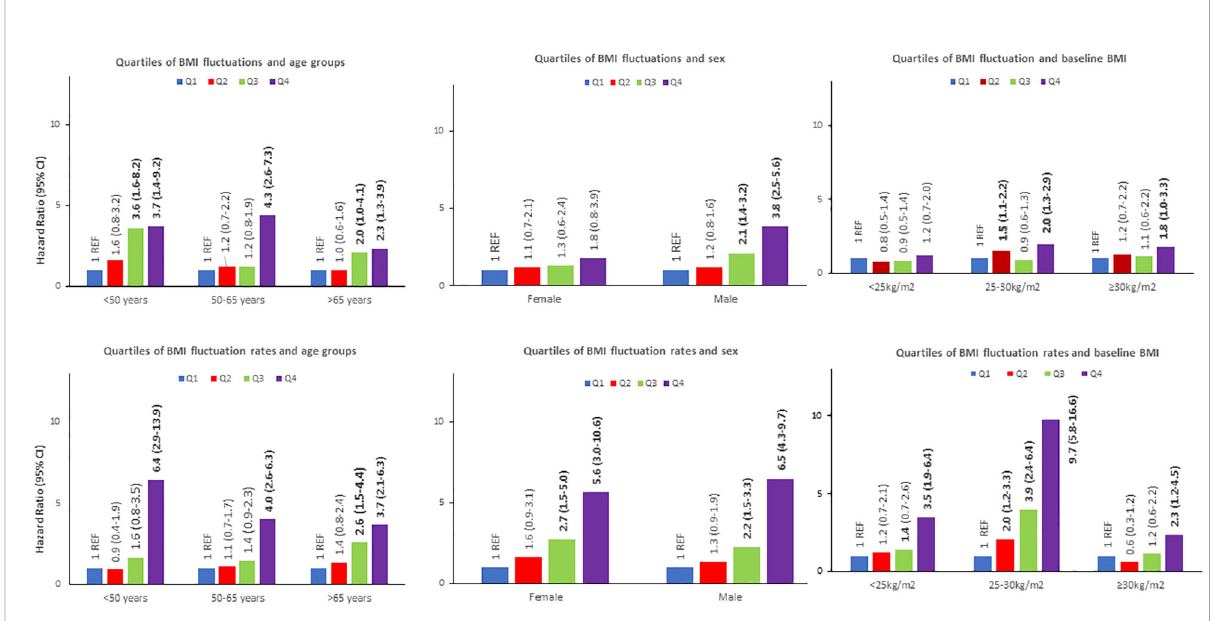
FIGURE 2 Absolute body mass index (BMI) fl uctuation (|kg/m2|) and absolute BMI fl uctuation rates (|kg/m2/year|) in fl uence on the risk of developing a CVD according to age groups, sex and baseline